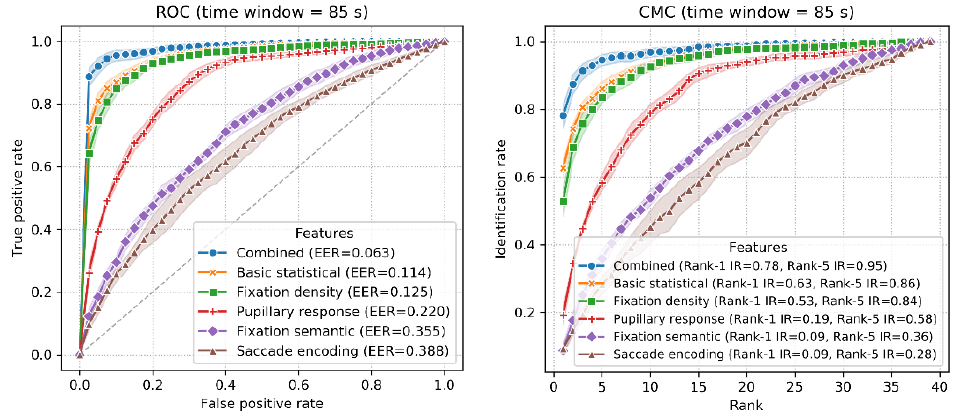
Figure 8. ROC ( left ) and CMC ( right ) curves in the 10-fold classification (T win = 85 s).